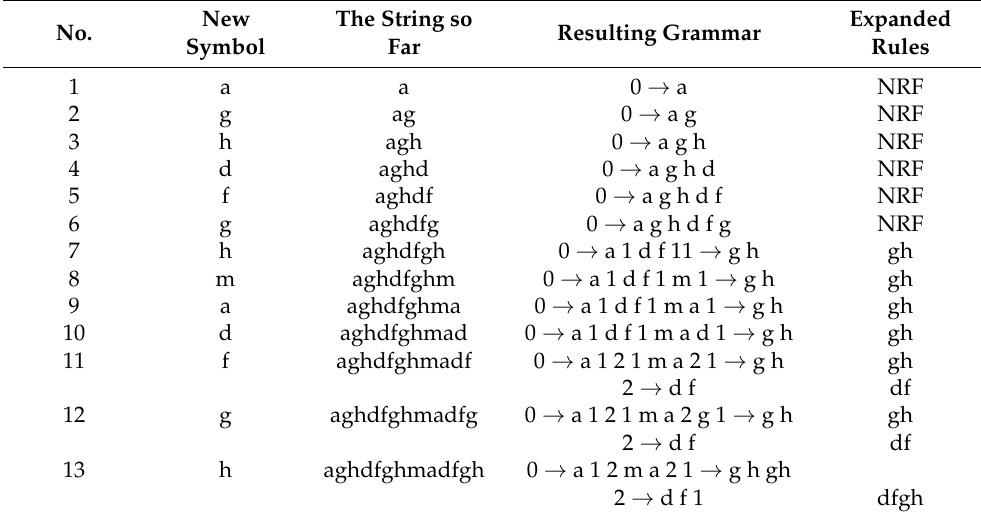
Table 1. Operation of the Sequitur algorithm. NRF = No rules found. No.